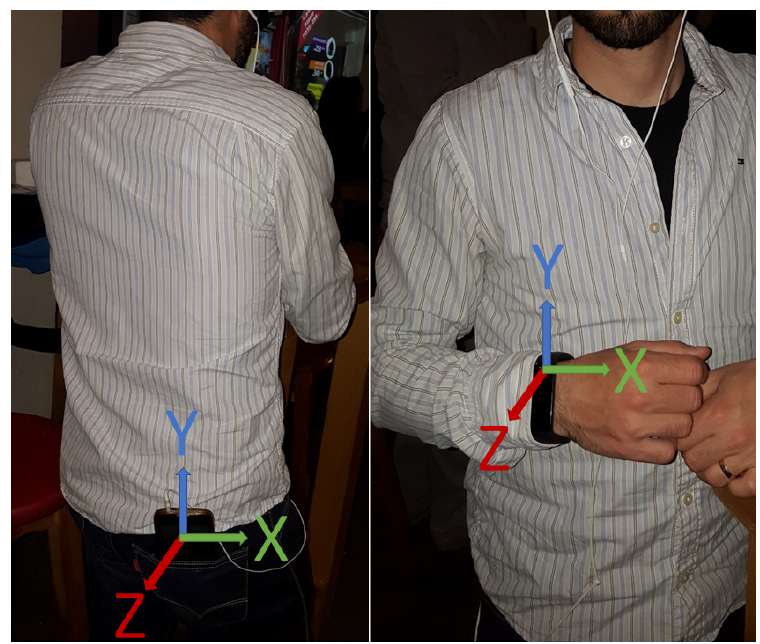
Figure 2. A subject outfitted with a Microsoft Band and Samsung Galaxy